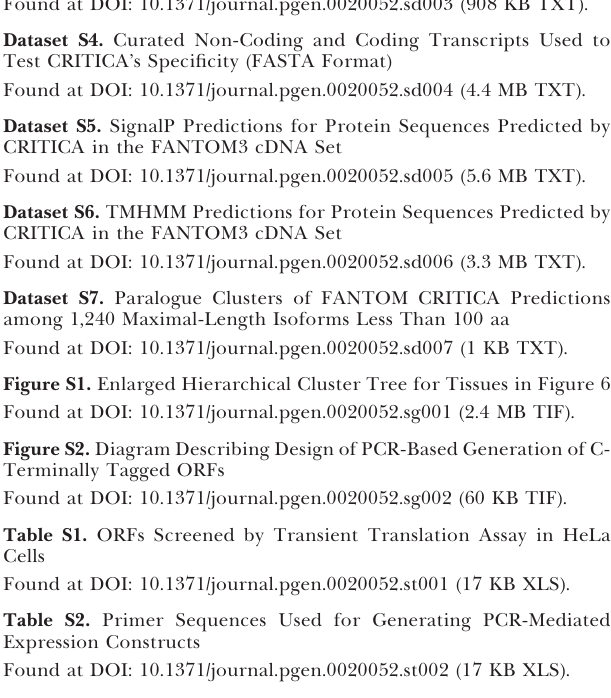
Figure S1. Enlarged Hierarchical Cluster Tree for Tissues in Figure 6 Found at DOI: 10.1371/journal.pgen.0020052.sg001 (2.4 MB TIF). Figure S2. Diagram Describing Design of PCR-Based Generation of C- Terminally Tagged ORFs Found at DOI: 10.1371/journal.pgen.0020052.sg002 (60 KB TIF). Table S1. ORFs Screened by Transient Translation Assay in HeLa Cells Found at DOI: 10.1371/journal.pgen.0020052.st001 (17 KB XLS). Table S2. Primer Sequences Used for Generating PCR-Mediated Expression Constructs Found at DOI: 10.1371/journal.pgen.0020052.st002 (17 KB